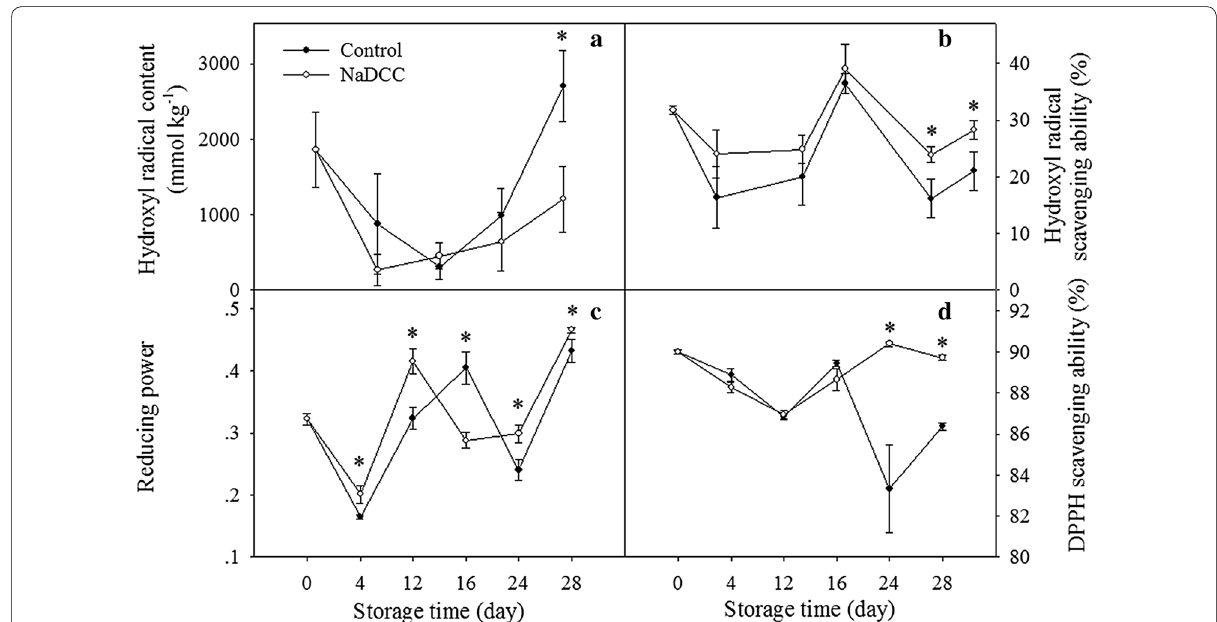
Fig. 6 Changes in hydroxyl radical content ( a ), hydroxyl radical scavenging ability ( b ), reducing power ( c ) and DPPH scavenging ability ( d ) of banana fruit during storage. Each data point represents a mean (from three separate groups) are significantly different ( p <